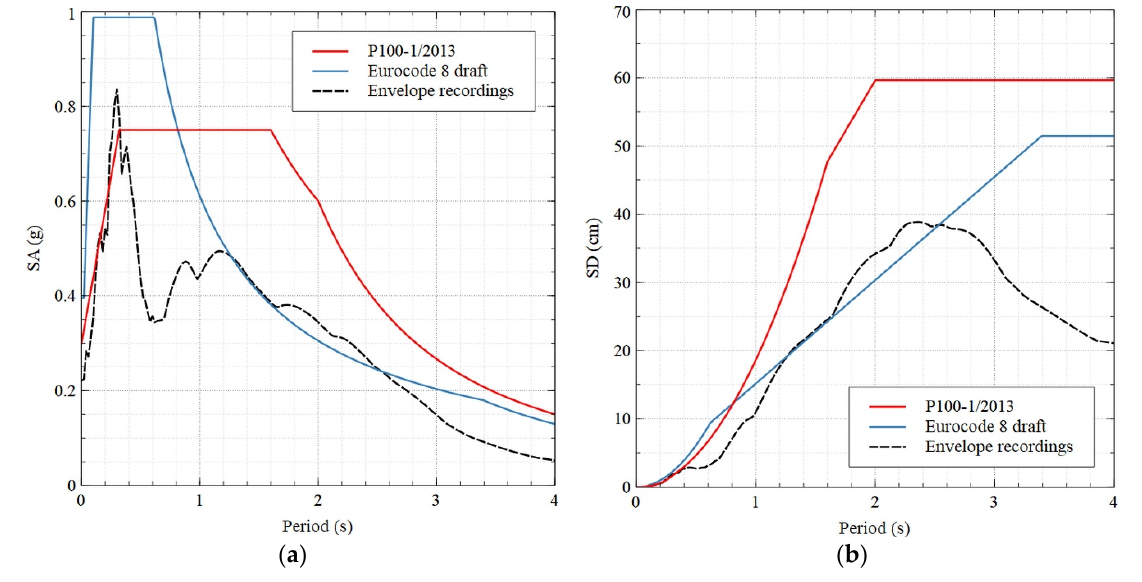
Figure 7. ( a ) A comparison between the design absolute acceleration response spectra from P100-1/2013 [29] (mean return period of 225 years), the Eurocode 8 draft revision [1] (mean return period of 475 years) and the envelope of the spectral accelerations from the ground motions recorded in the Bucharest area during Vrancea intermediate-depth earthquakes; ( b ) a comparison between the design displacement response spectra from P100-1/2013 [29] (mean return period of 225 years), the Eurocode 8 draft revision [1] (mean return period of 475 years) and the envelope of the spectral displacements from the ground motions recorded in the Bucharest area during Vrancea intermediate-depth earthquakes.